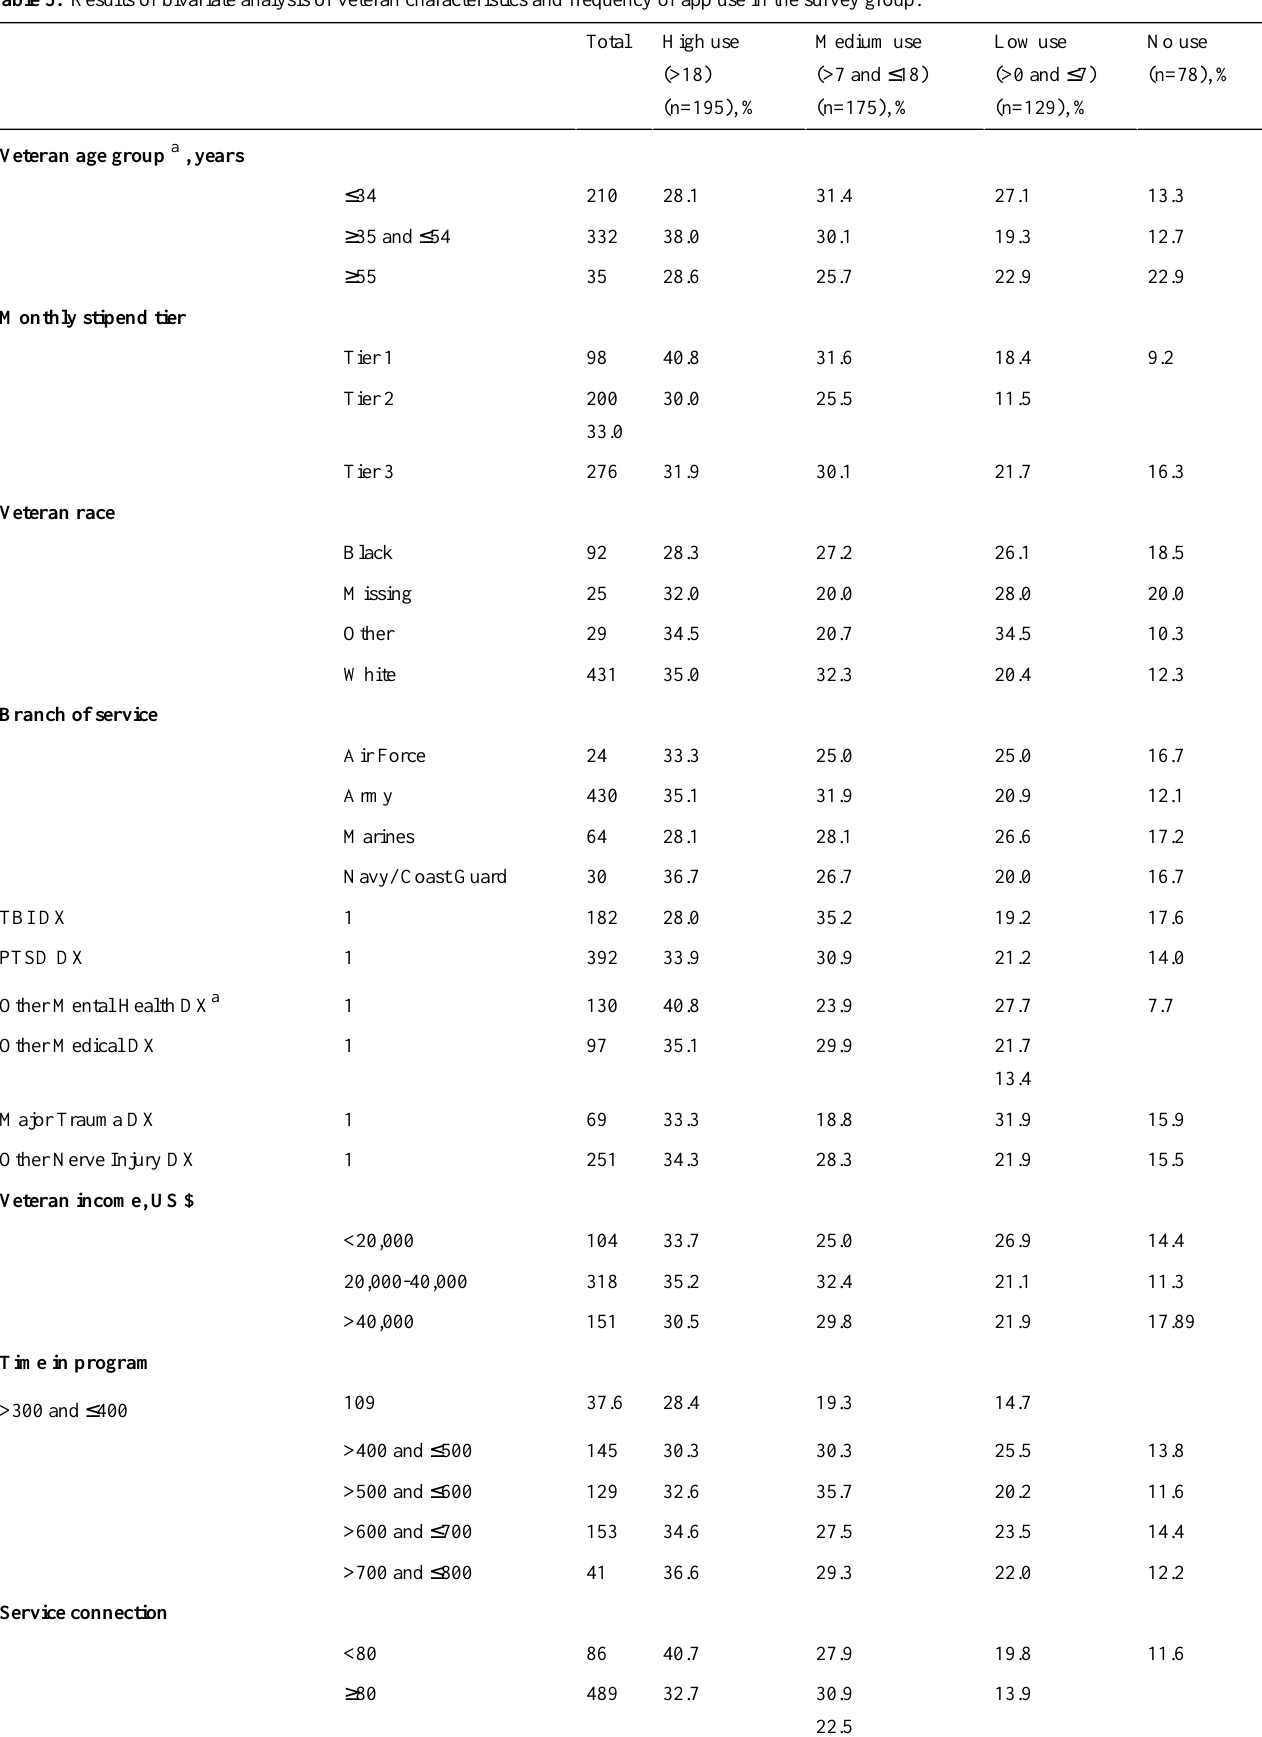
Table 5. Results of bivariate analysis of veteran characteristics and frequency of app use in the survey